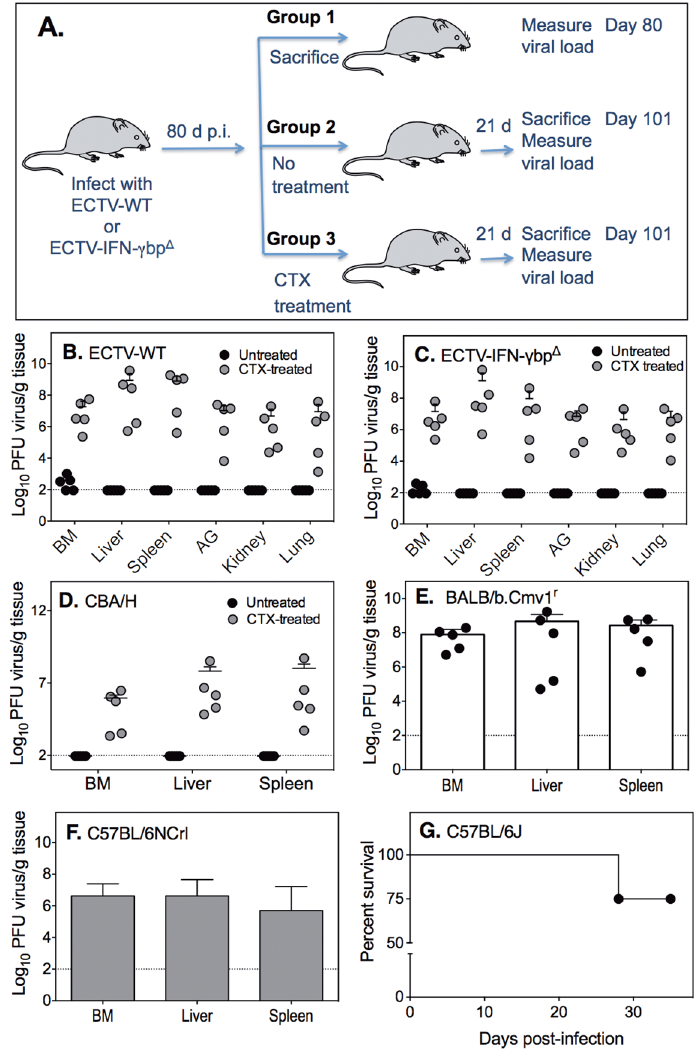
Fig 6. Immunosuppression with CTX triggers ECTV replication. (A) Experimental scheme. Groups of 5 WT BALB/c mice were infected with 100 PFU of ECTV-WT or ECTV-IFN- γ bp Δ . Group 1 was sacrificed 80 days p.i. to measure viral load in various tissues, Group 2 was left untreated and Group 3 was treated with CTX. Three weeks later (day 101 p.i.), CTX-treated and untreated mice were sacrificed to measure viral load in organs. (B) ECTV-WT and (C) ECTV-IFN- γ bp Δ titers in organs of untreated or CTX-treated mice at 101 days p.i. BM, bone marrow; AG, adrenal gland. (D) CBA/H mice (n = 5/group) were infected with 100 PFU of ECTV-WT and 80 days p.i., one group was treated with CTX and the second group was left untreated. Shown are ECTV-WT titers in organs of untreated or CTX-treated CBA/H mice at 101 days p.i. For panels B-D, P < 0.01 by Mann-Whitney U test for differences between untreated and CTX treated groups. (E) BALB/b. Cmv 1 r mice (n = 5) were infected with 10 5 PFU of ECTV-IFN- α / β bp Δ and 80 days later treated with CTX 3 times over 15 days and sacrificed at 21 days post commencement of treatment (101 days p.i). (F) C57BL/NCrl (n = 3) and (G) C57BL/6J (n = 4) were infected with 1000 PFU of ECTV-WT and 80 days p.i., treated with CTX 4 times over 20 days. (F) ECTV-WT titers in organs of CTX-treated C57BL/6NCrl mice at 28 days post commencement of treatment (108 days p.i.) (G) Survival of C57BL/6J mice post commencement of treatment with CTX. One mouse that died on day 28 had high titers of virus in liver and spleen whereas no infectivity was detected in the organs of the remaining 3 animals that were sacrificed 35 days post commencement of treatment with